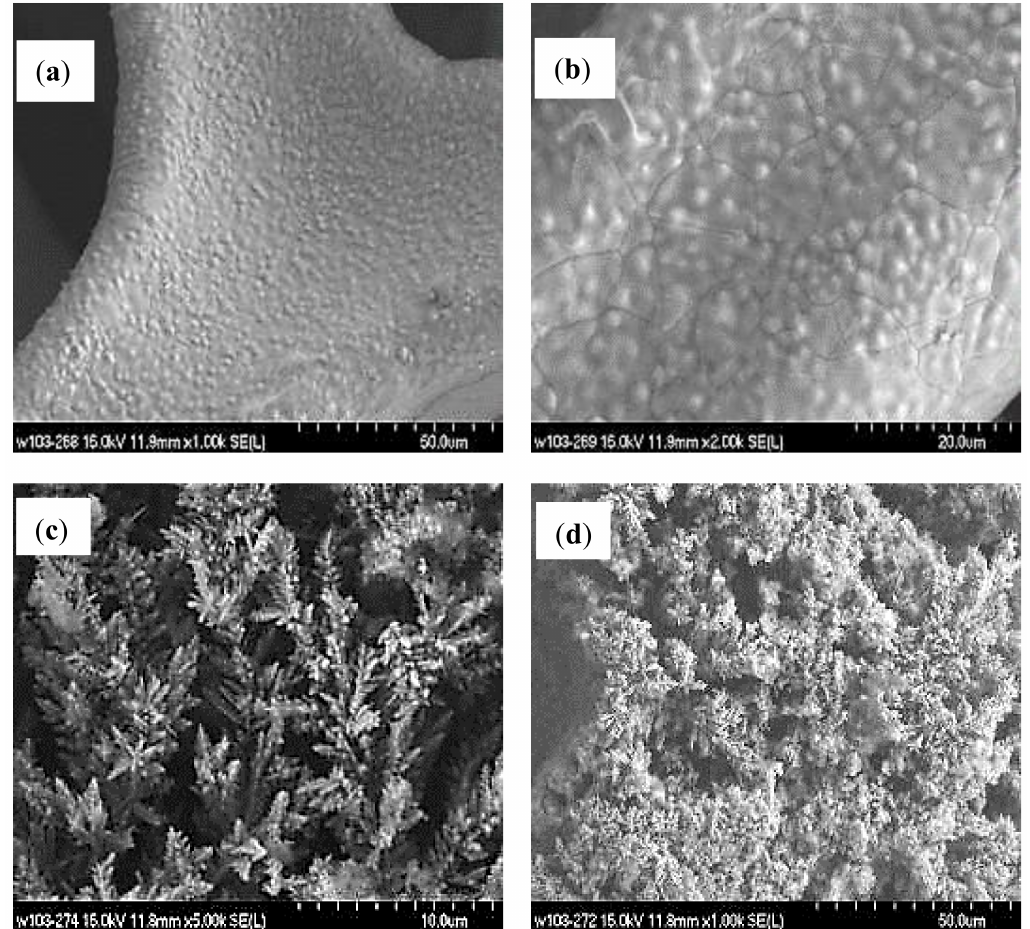
Figure 1. SEM micrographs of ( a ) foam nickel substrate (1000 × ), ( b ) foam nickel substrate (2000 × ), ( c ) Pd/Ni electrode (5000 × ) and ( d ) Pd/Ni electrode (1000 ×